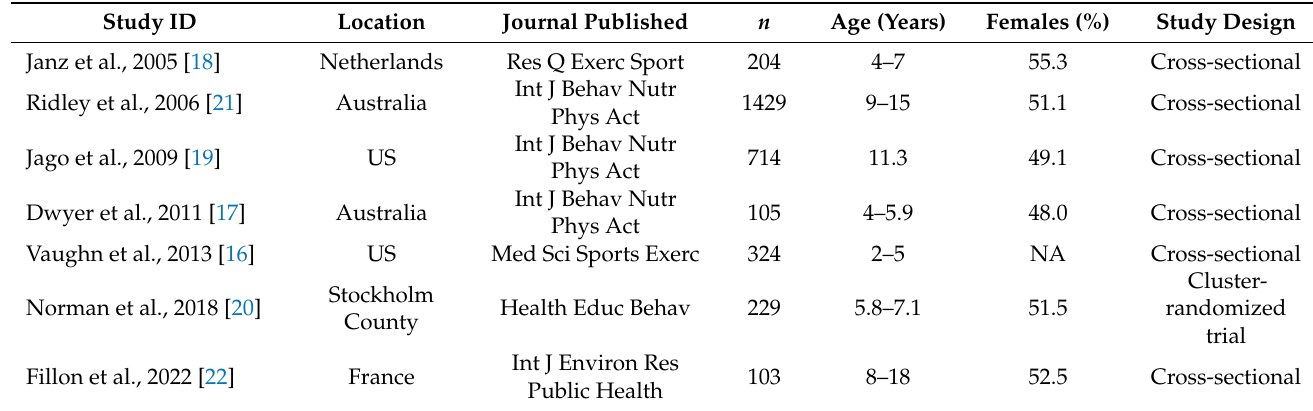
Table 1. Description of the included studies ( n =